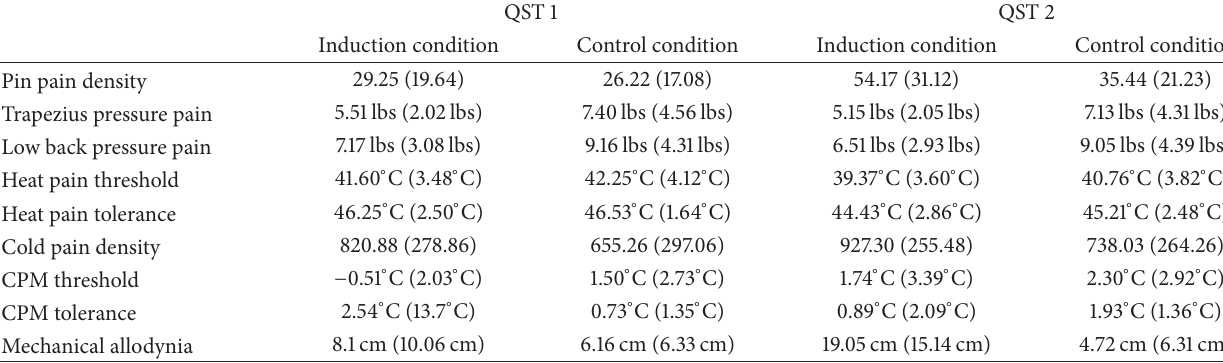
Table 2: Means and standard deviations for all QST assessments for the induction and control conditions at QST 1 and QST 2.